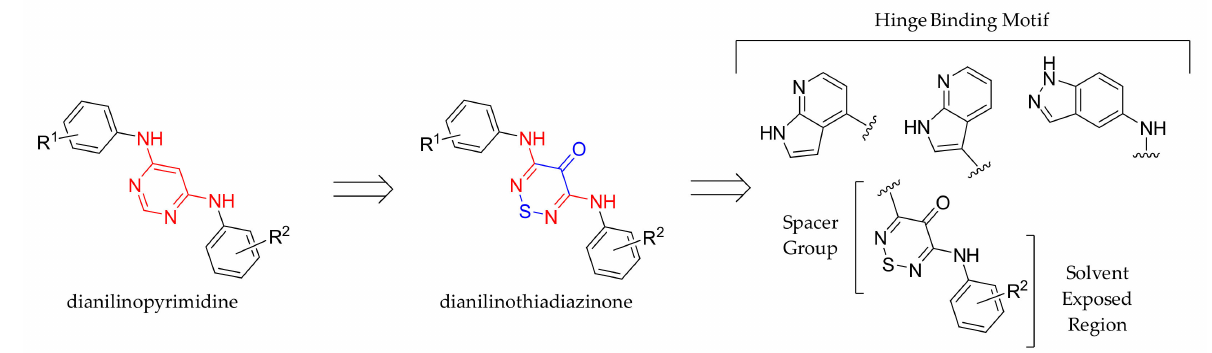
Figure 2. Design rational of novel 1,2,6-thiadiazinone